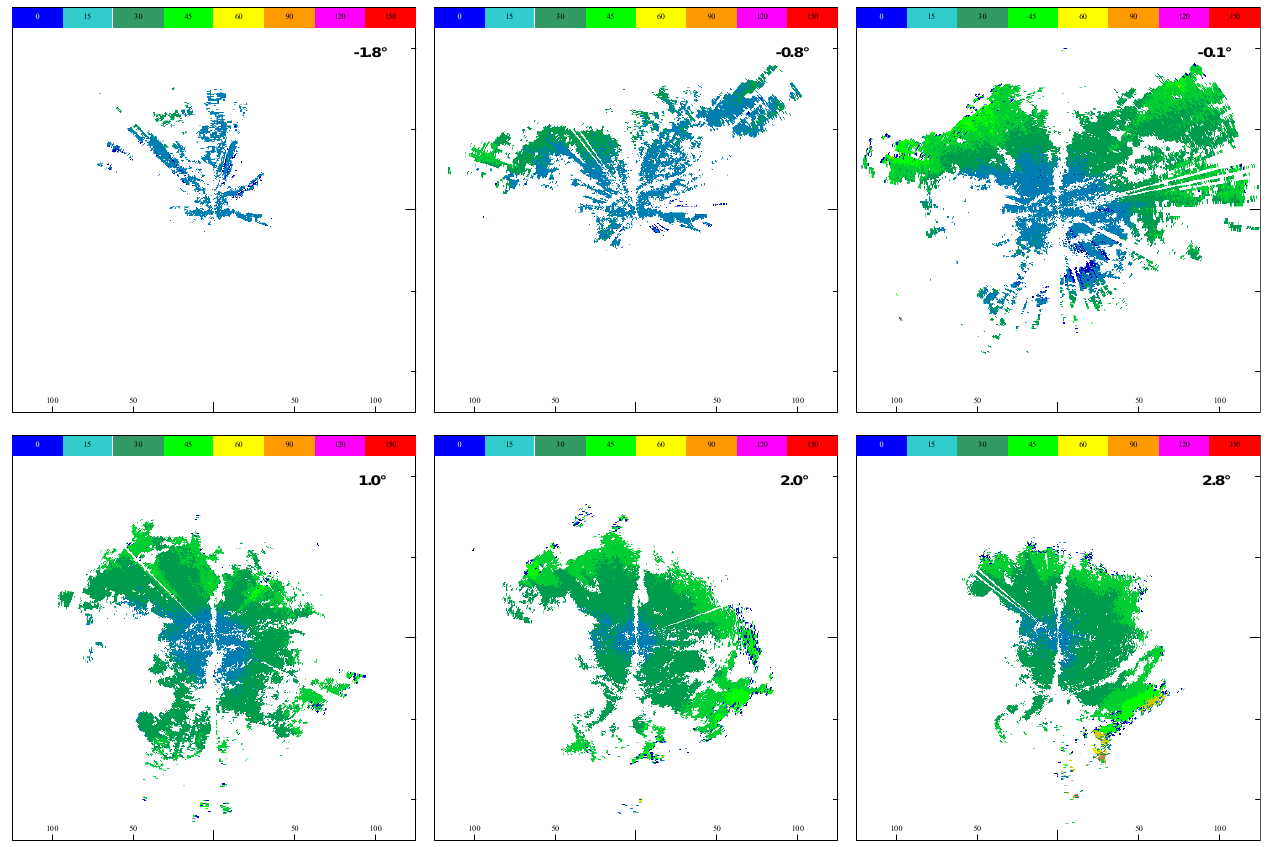
Fig. 5: PPI scans of φ DP [degree] at various elevation angles from –1.8° to 2.8° (August 28, 2007, 0837 UTC). Fig. 5. PPI scans of ϕ DP [degree] at various elevation angles from − 1.8 ◦ to 2.8 ◦ (28 August 2007,